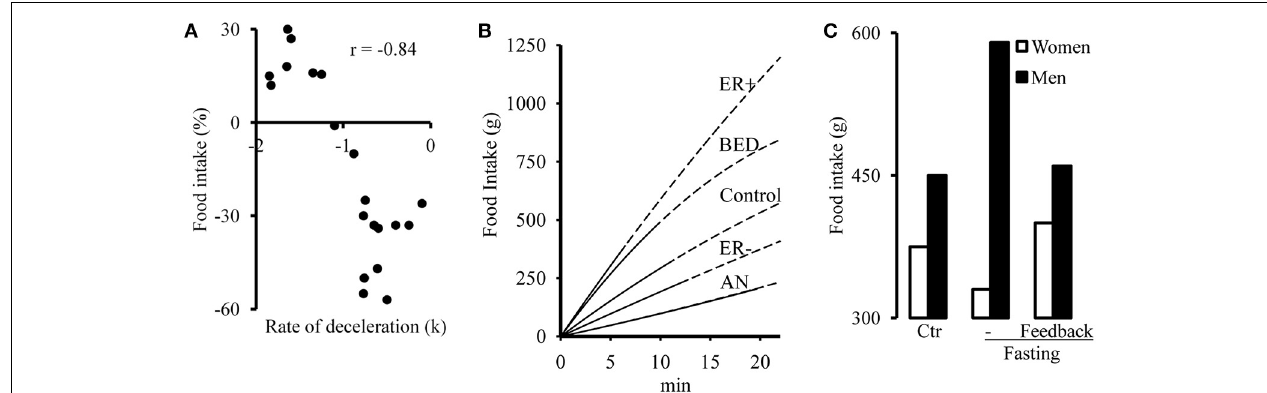
FIGURE 1 | (A) Effect of omitted eating dinner on food intake at lunch in 20 women as a function of deceleration (k) of the speed of eating in their un-deprived condition. y = kx 2 + lx; y = food intake, k = deceleration, i.e., rate at which the speed of eating changes over the course of the meal, l = initial speed of eating and x = time. The k -values are from a lunch in the un-deprived condition and the change in food intake is expressed as the percent of that lunch after the women. (B) Cumulative food intake in women who ate at a nearly constant rate (k ∼ 0, n = 16) and female patients with anorexia nervosa (AN, n = 16) or Binge Eating Disorder (BED, n = 12). The